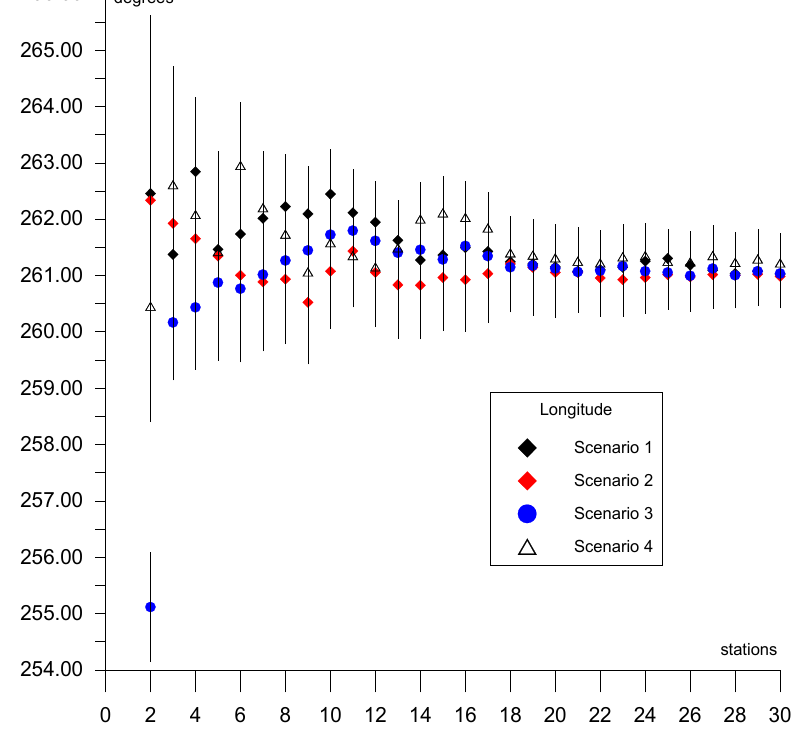
Figure 5. Results of the sequential solutions of the Λ parameter for four calculation scenarios.